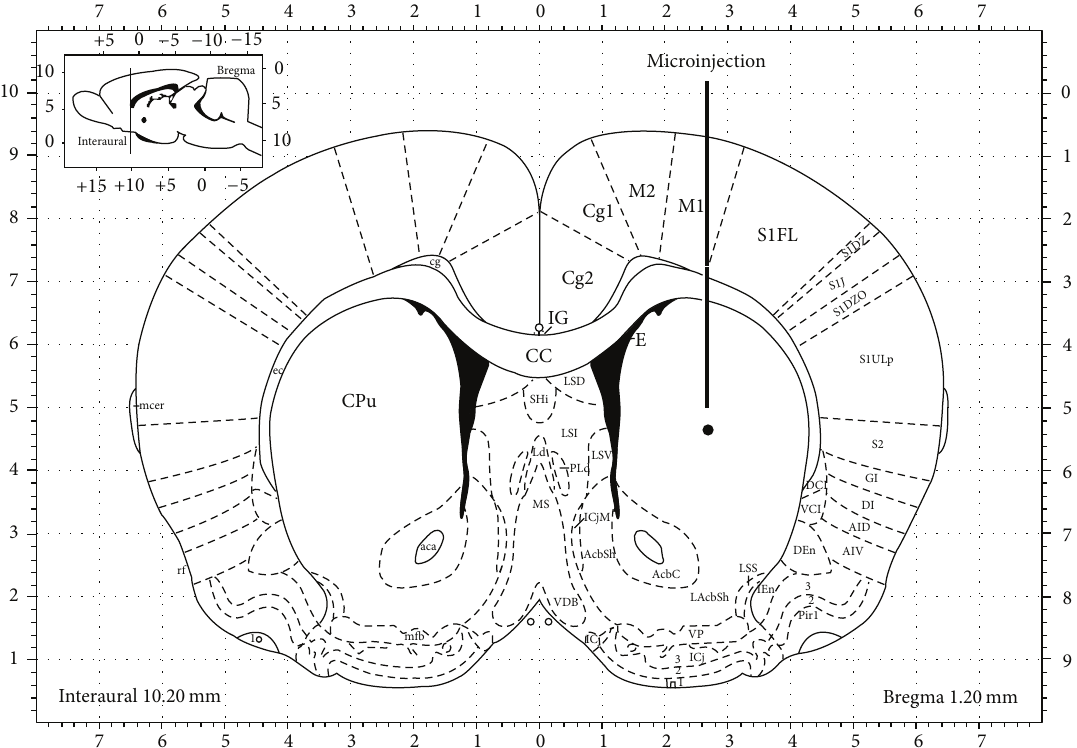
Figure 1: Schematic representation of a brain coronary section showing the corpus striatum and the place where microinjections were performed. Coordinates: Anterior-Posterior, +1.2 mm; Mediolateral, +2.5 mm; Dorsoventral, − 6.5 mm relative to bregma. CC, corpus callosum; CPu, caudate putamen (modified from Paxinos G. and Watson C, 1997; The Rat Brain in Stereotaxic Coordinates , third